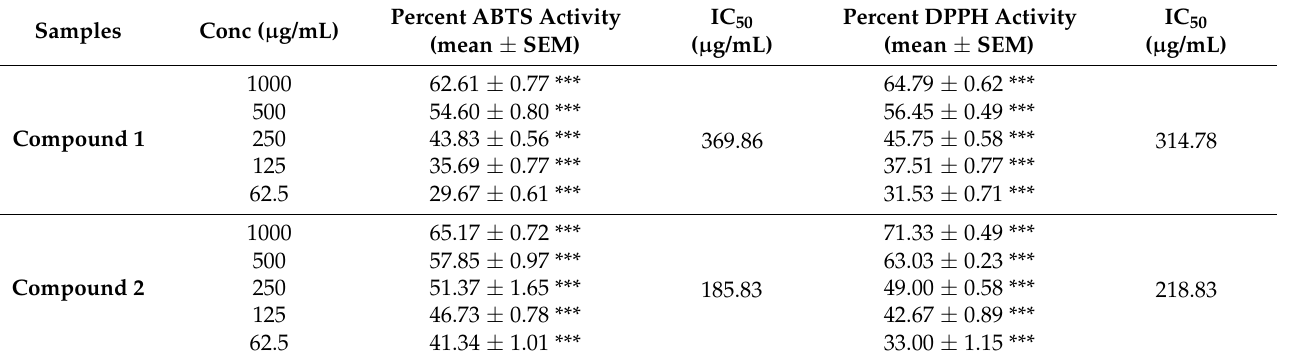
Table 3. Percent DPPH and ABTS activity of isolated